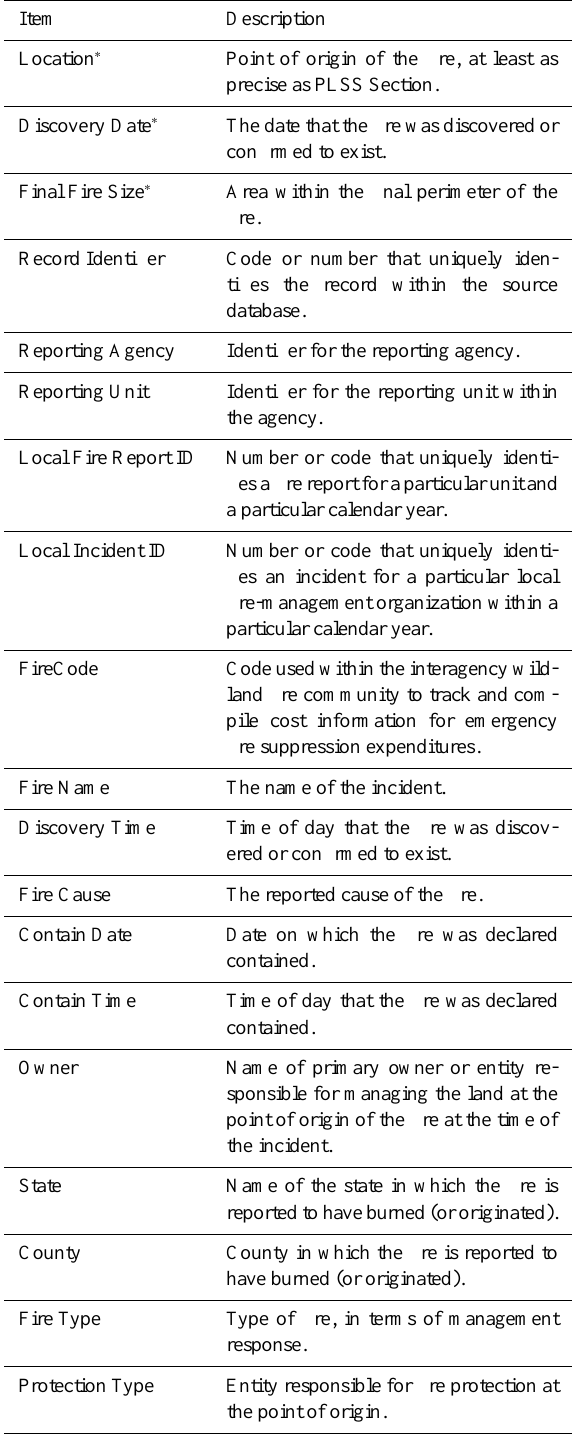
Table 2. Data elements extracted from wildfire reports and used to populate the FPA